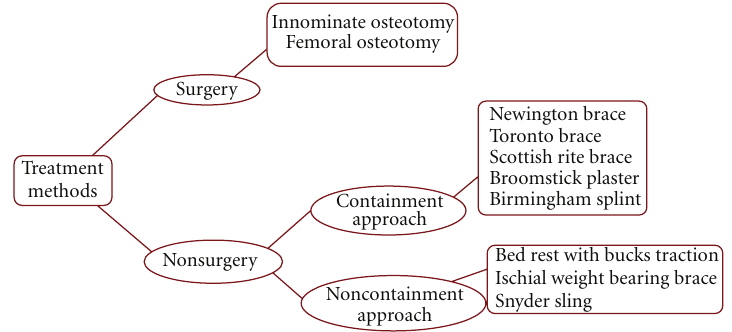
Figure 1: Operative and nonoperative treatment of LCPD.